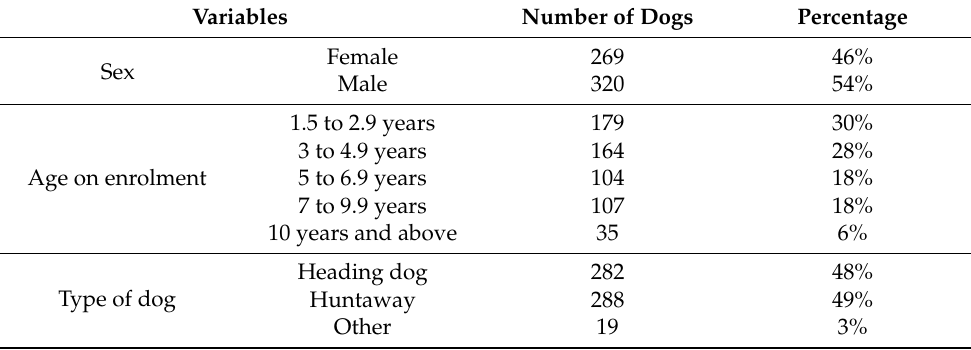
Table 2. Population data relating to 589 working farm dogs that were enrolled in TeamMate and included in the risk factor